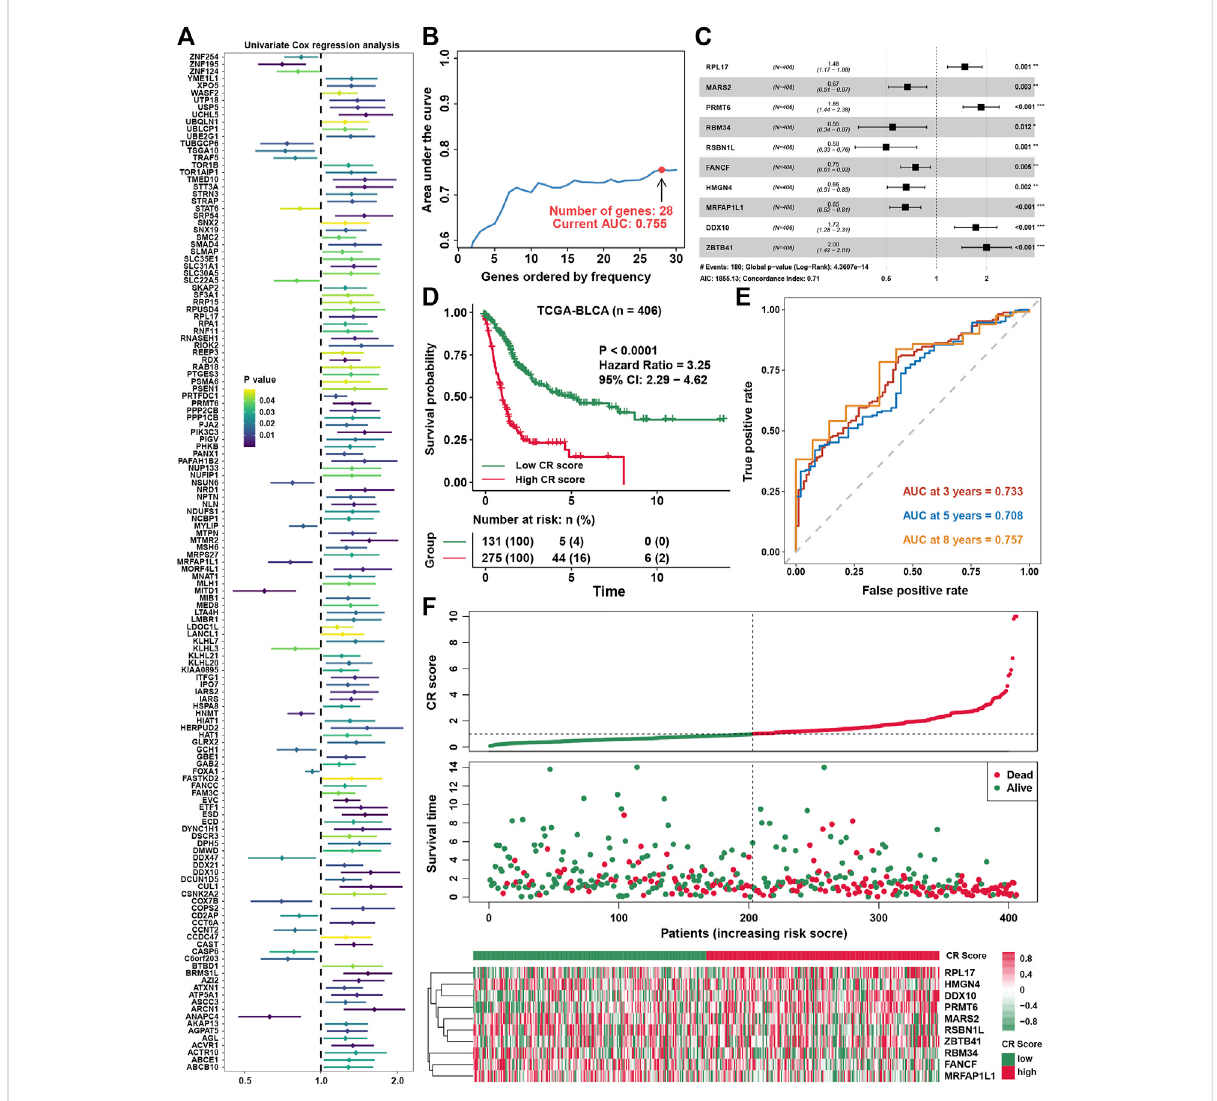
FIGURE 5 Constructing a prognostic signature in BLCA (A) . Univariate COX regression analysis for cuproptosis-related genes (B) . The variation tendency of AUC with the change of genes ordered by frequency (C) . Multivariate COX regression for constructing a prognostic signature in BLCA (D) .The survival analysis for low- and high-CR scores in BLCA (E) . ROC curves plotted for 3-, 5-, and 8-y overall survival (F) . The vital status of patients in the high-risk and low-risk groups with changes in CR scores, and a heatmap of the expression pro fi les of members in the gene